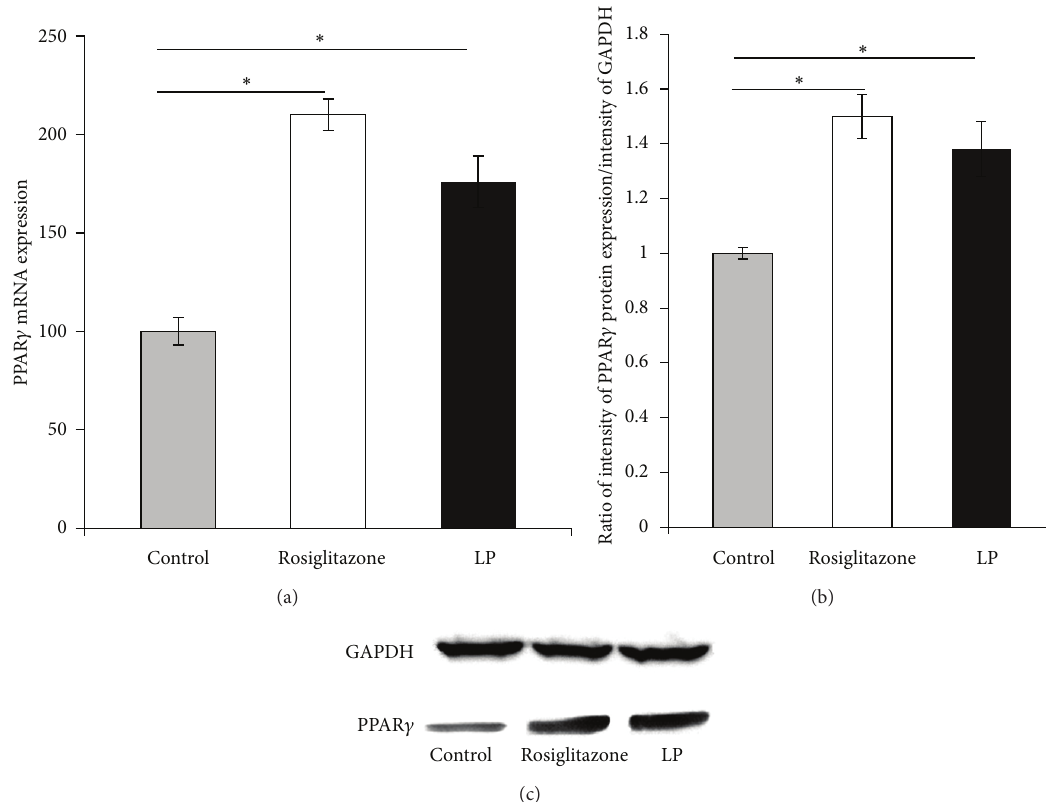
Figure 2: Effect of LP mRNA and protein expressions on3T3-L1 adipocytes. (a) Relative PPARgamma mRNA expression in the 3T3-L1 ( 𝑛 = 10 ). ∗ 𝑃 < 0.05 . The mRNA was corrected by 𝛽 -actin. The level of the expression in the control group was arbitrarily set at 100%. (b) Quantitative blot of PPARgamma protein in 3T3-L1 adipocytes. (c) Representative Western blot of PPARgamma protein in 3T3-L1. Western blots of total protein were probed with anti-PPARgamma antibodies and then reprobed with anti-GAPDH to confirm equal loading. Densitometric analyses presented as the relative ratio of PPARgamma to GAPDH. The results represent mean ± SEM from 3 independent experiments. ∗ 𝑃 < 0.05 as determined by the Mann-Whitney 𝑈